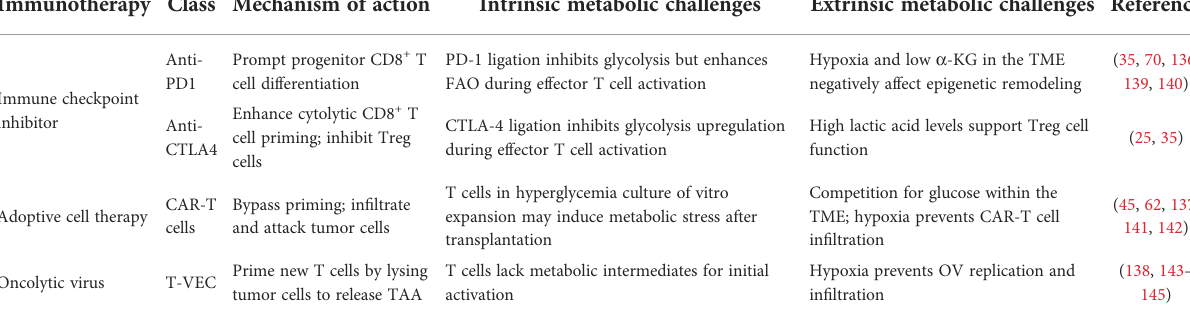
TABLE 3 The mechanism of metabolic barriers of different